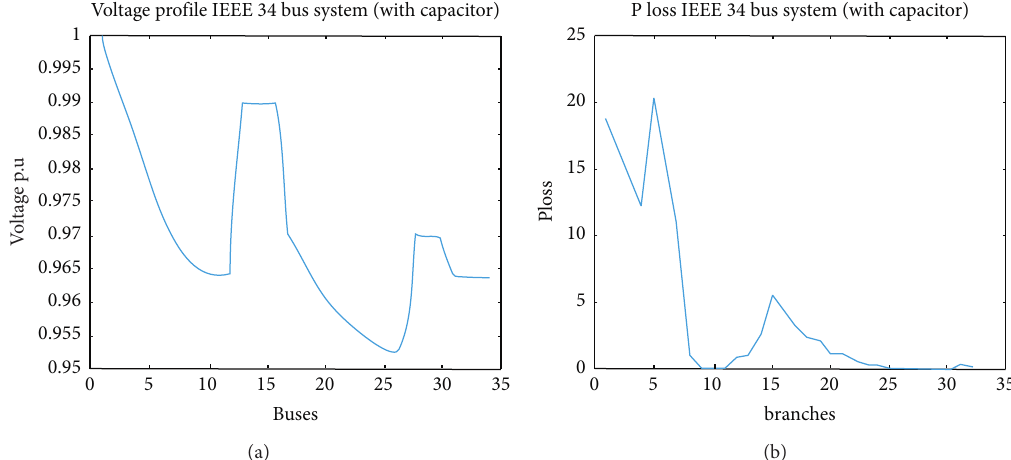
Figure 12: GWO (a) Voltage profile after kVAR compensation IEEE-34 bus system. (b) Power loss after kVAR compensation IEEE- 34 bus system.